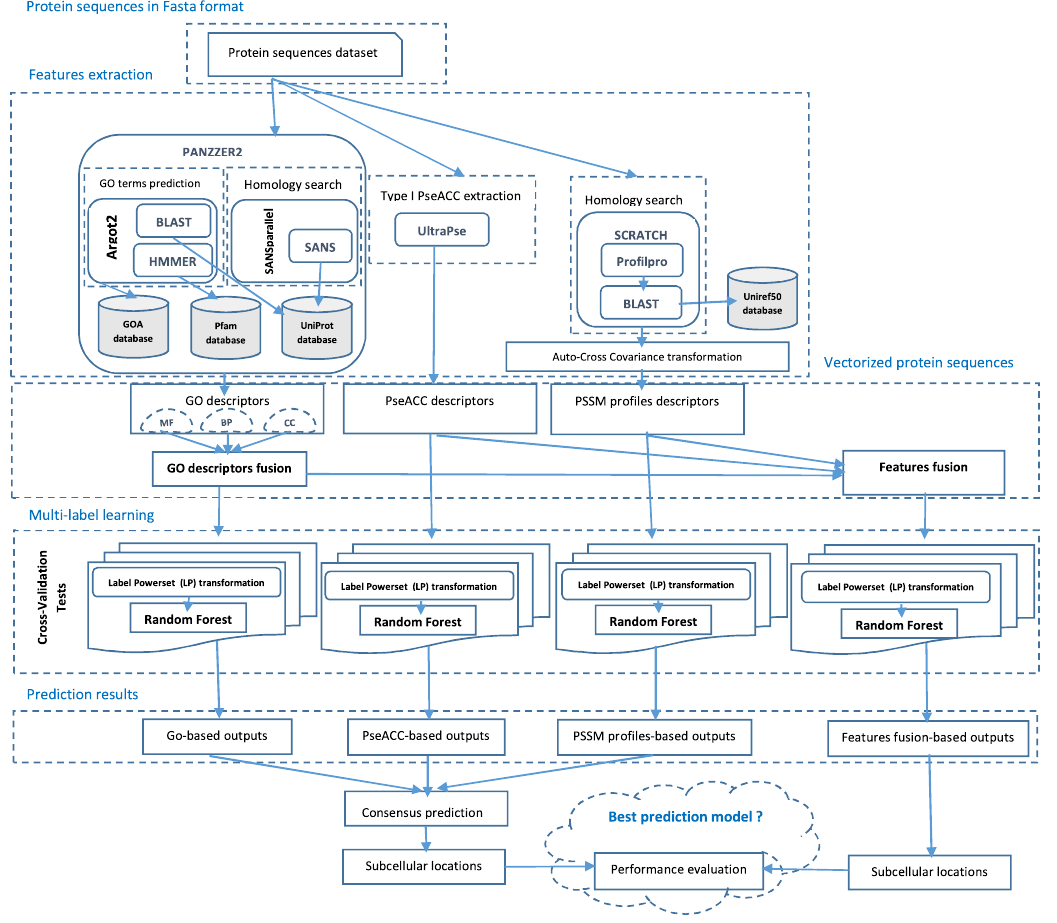
Figure 1: Flowchart for the proposed prediction model for Gram-positive and Gram-negative bacterial proteins subcellular localization.Firstly,proteinsequencesdatasetswerecollectedfromthepublisheddatabase.Secondly,theywerefilteredoutand preprocessed using different strategies to obtain a fixed size feature vector representation that can be fed into the learning